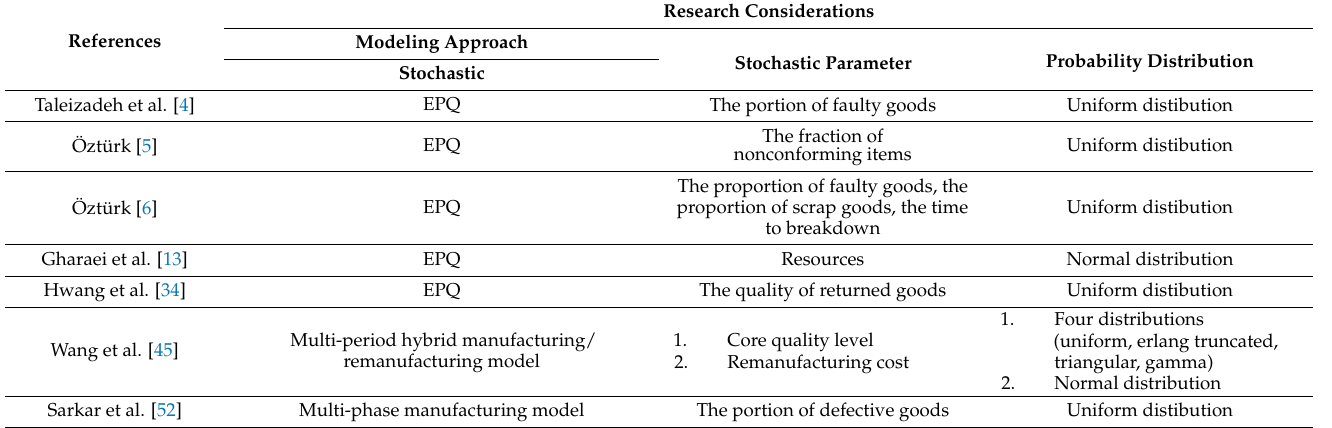
Table 2. Information on stochastic model-related